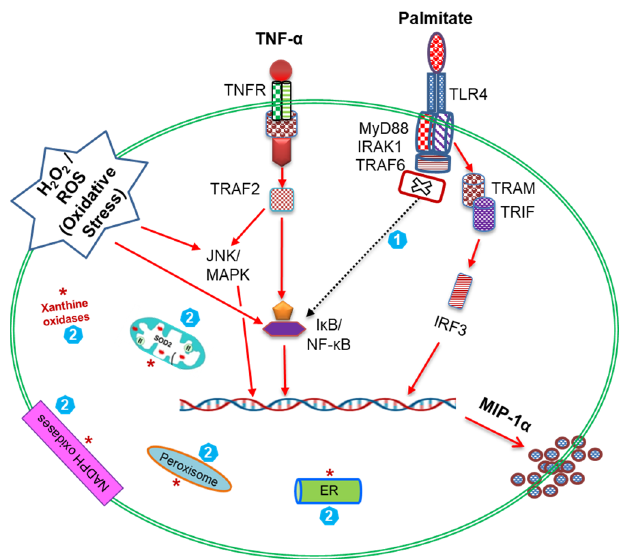
Figure 8. The “cooperativity model of MIP-1α amplification” in THP-1 monocytic cells. A schematic illustration shows that palmitate-TLR4 interaction activates downstream signaling via the TRIF/IRF3 pathway for MIP-1α expression. While, TNF-α-TNFR1 interaction and TRAF2 engagement activate signaling via the NF-κB and JNK/MAPK pathways and lead to MIP-1α expression. Notably, ROS-mediated oxidative stress also leads to activation of the NF- κ B and JNK / MAPK pathways and MIP-1 α expression. Taken together, the simultaneous exposure of THP-1 cells to the three agonistic stimuli i.e., palmitate, TNF- α and H 2 O 2 likely transduces a strong cooperative signaling cascade (red arrows) resulting in the amplified MIP-1 α expression. Note: (1) This model highlights the novel finding that cooperative MIP-1 α expression, unlike MIP-1 β expression, does not involve the MyD88 signaling pathway (cross sign with dashed arrow); (2) The intracellular sources of endogenous ROS are shown by red asterisks that include the membrane bound NADPH oxidases, cytoplasmic xanthine oxidases, endoplasmic reticulum, mitochondria, and peroxisomes.